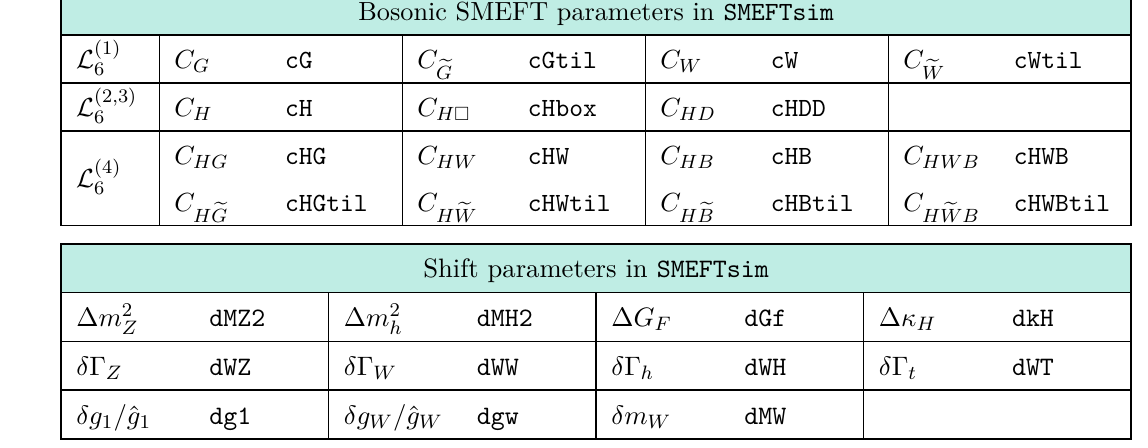
Table 17 . Upper block: Wilson coefficients for the 15 bosonic operators. They are common to all flavor versions except MFV , where the CP violating C defined. Lower block: shift parameters defined